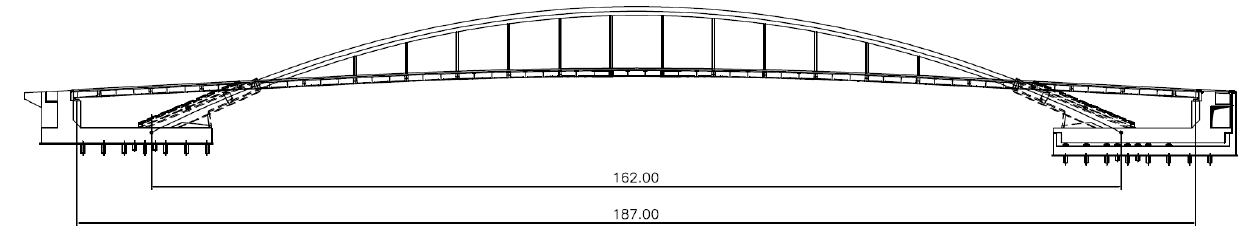
Figure 2. Structural scheme of the investigated bridge.